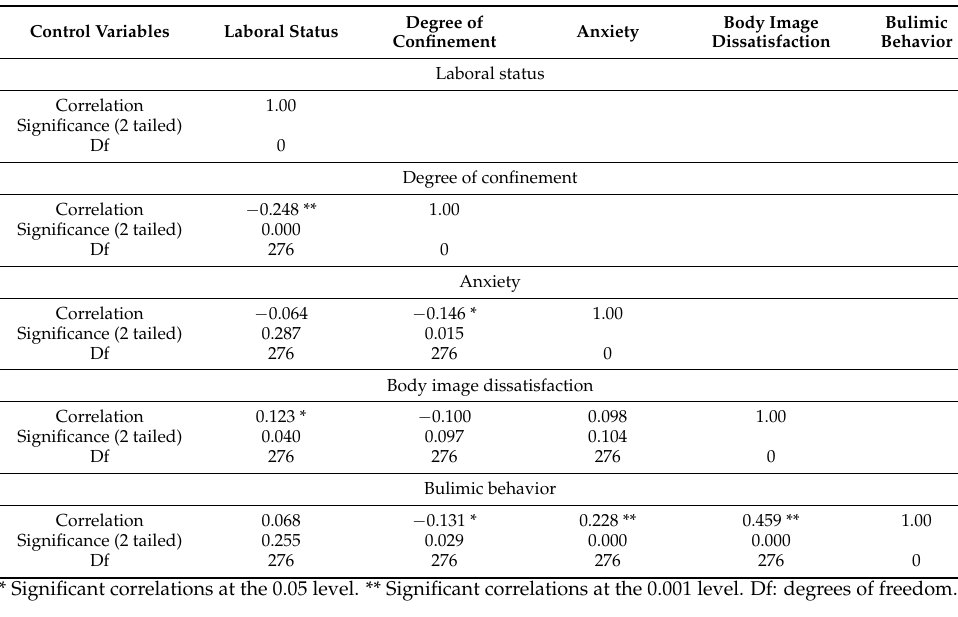
Table 2. Bivariate partial Pearson correlations among labor status, degree of confinement, anxiety, body dissatisfaction, and bulimic behavior, controlled for gender and age. A p -value < 0.05 was considered statistically significant.